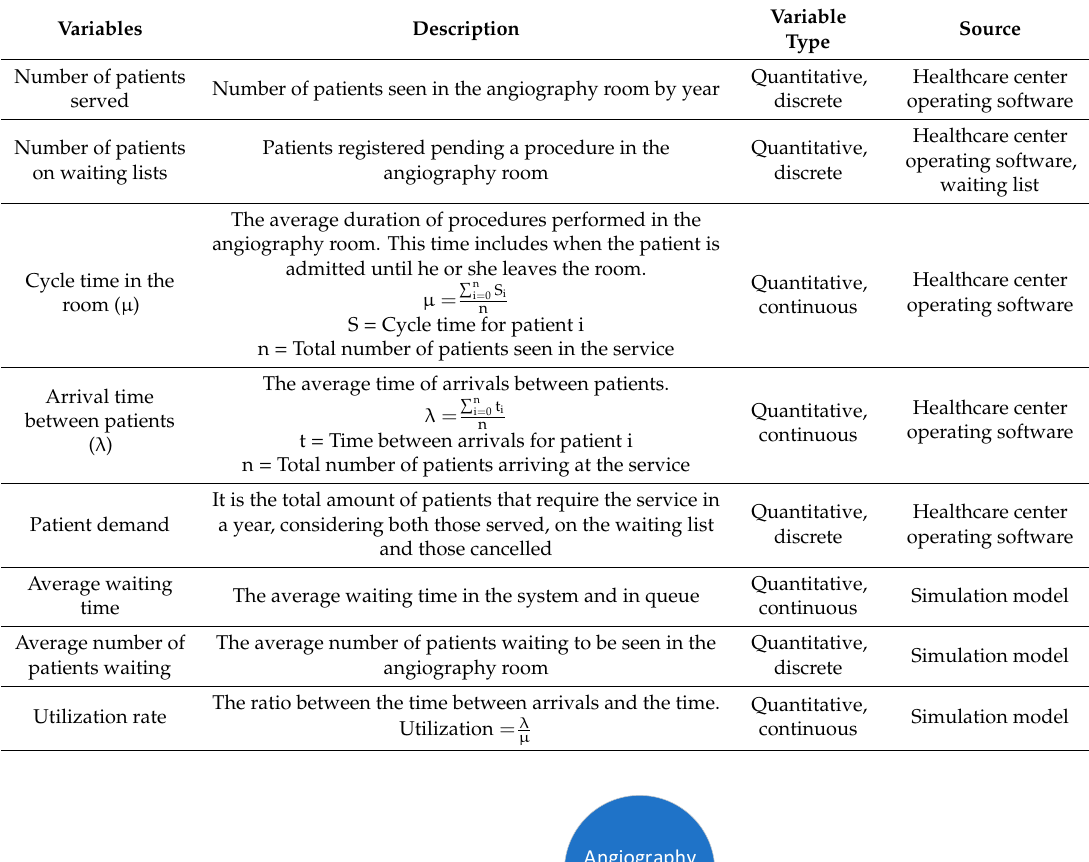
Table 1. Data collection plan for the study.